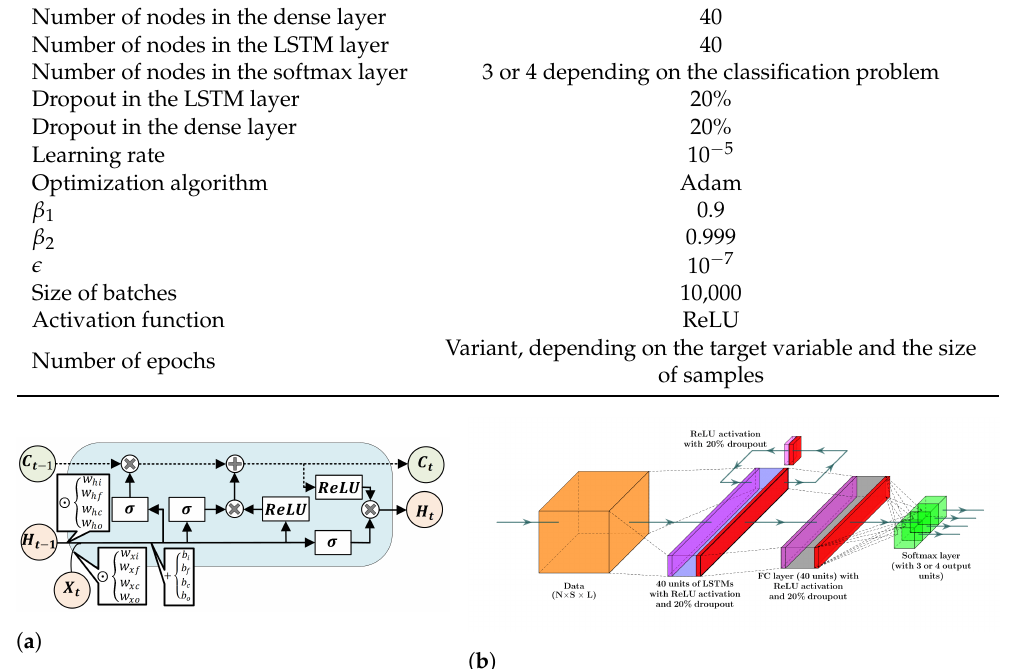
Figure 5. ( a ) The structure of a regular LSTM unit and ( b ) the architecture of an LSTM–Dense layer NN model. The size of the softmax layer was set to three units for estimating different variations of APS and PA and four units for estimating both